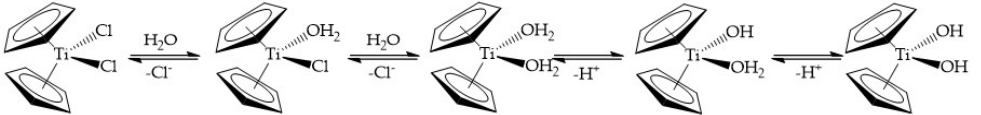
Figure 4. The hydrolysis of titanocene dichloride under acidic conditions focusing only on the dissociation of the chloro ligands. dissociation of the chloro